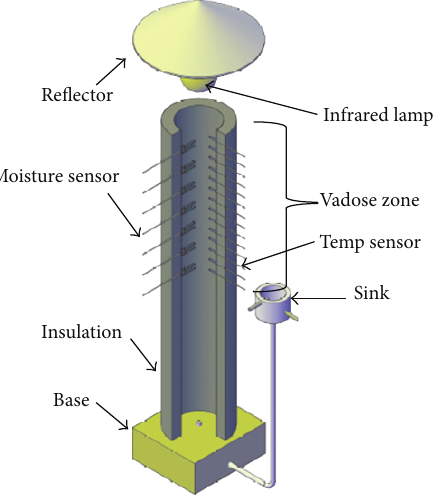
Figure 1: The schematic layout of the soil column apparatus as well as the layout of sensors within the